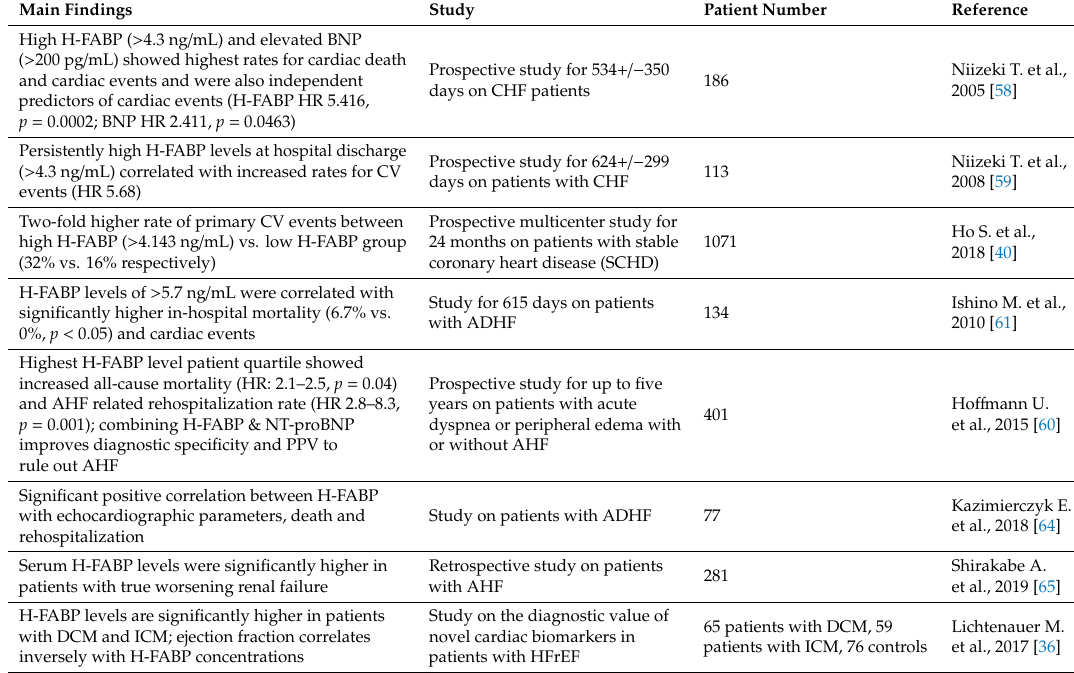
Table 1. Overview of di ff erent positive clinical studies assessing the diagnostic value of H-FABP (heart-type fatty acid-binding protein) in patients with heart failure (HF) (sorted by main topic and year of